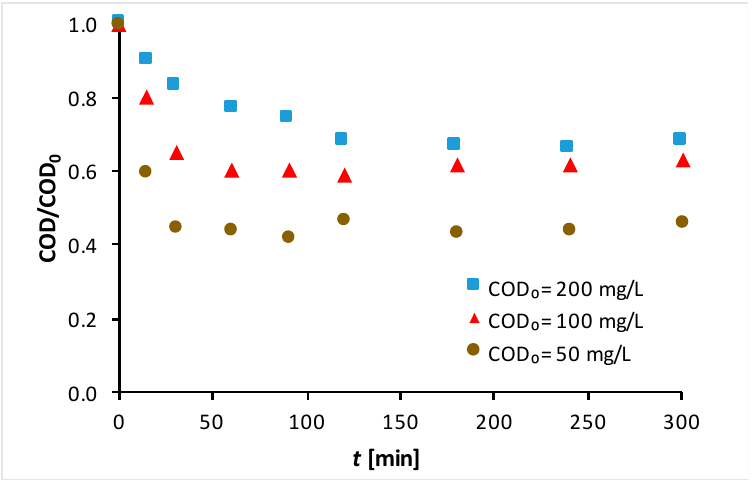
Figure 3. COD/COD 0 profile vs. reaction times for experiments carried out at different initial concentrations of COD. The experiments were conducted fixing ρ B = 0.5 g/L, T = 298 K, Q air = 1.0 × 10 − 6 m 3 /s, and v = 500 rpm.